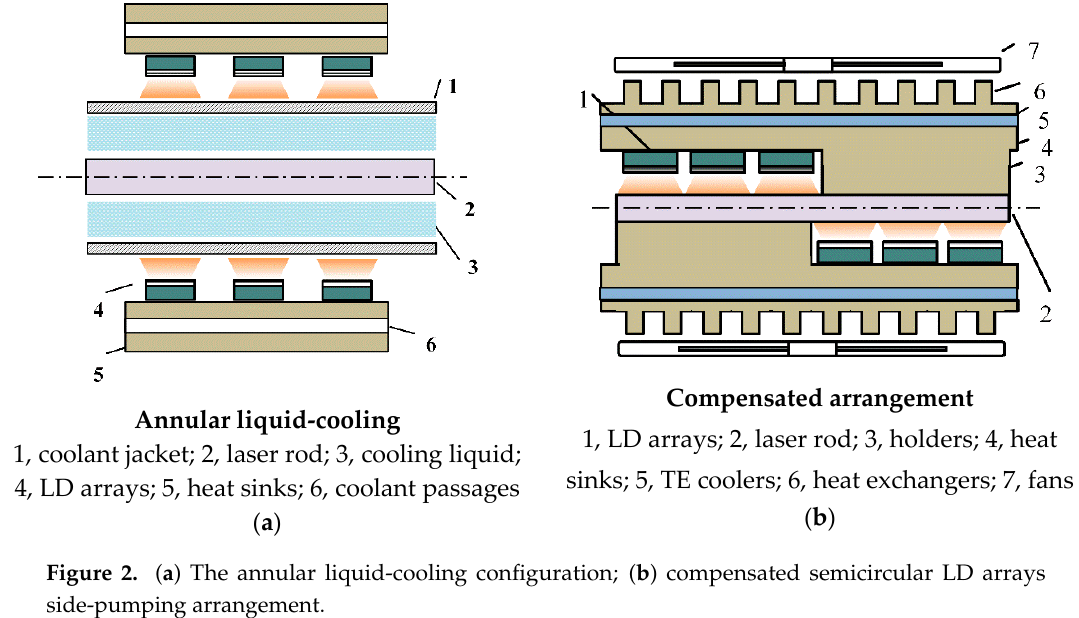
Figure 2. ( a ) The annular liquid-cooling configuration; ( b ) compensated semicircular LD arrays side-pumping arrangement.